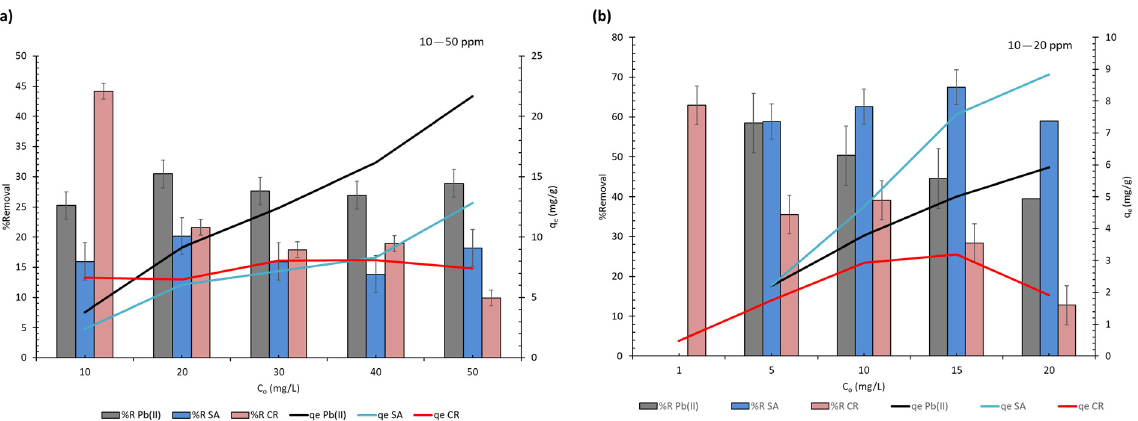
Figure 3. Effect of initial concentration on qe and %removal for the three tested contaminants at 25 ± 2 °C using ( a ) 0.67 g/L of CsXM in the range of 10–50 ppm, and ( b ) 1.33 g/L of CsXM in the range of 1–20 ppm. Adsorption was conducted at 5.5 ± 0.1, 4.0 ± 0.3, and 6.1 ± 0.2, for Pb(II), SA, and CR, respectively. Error bars are expressed as mean value ± SD ( n = 3).